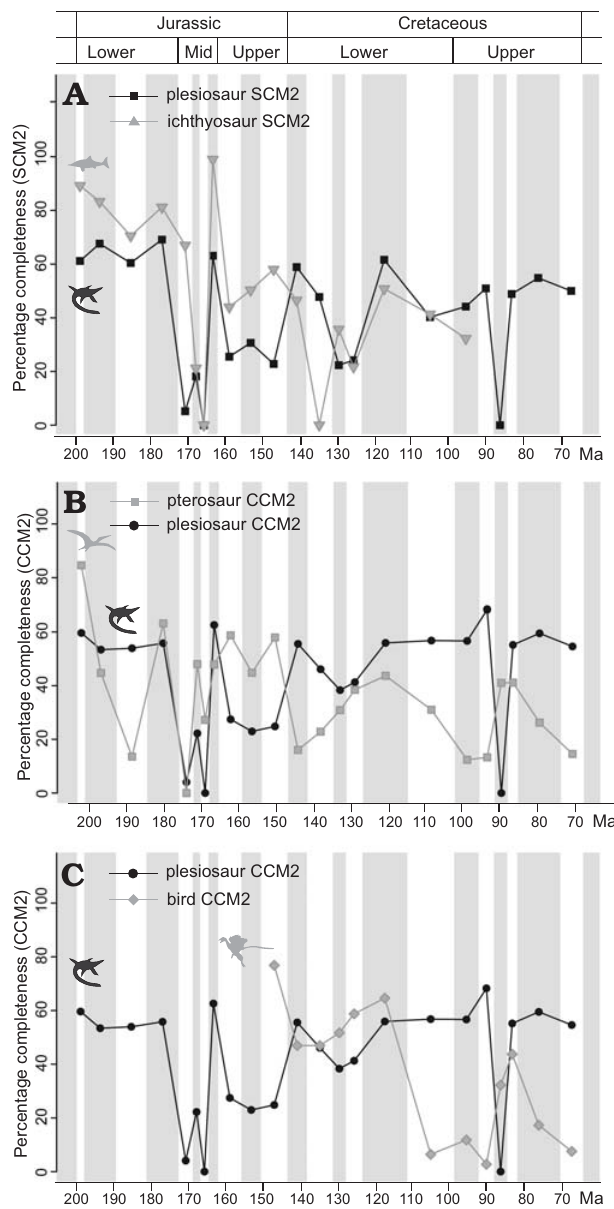
Fig. 4. Changes in skeletal completeness through time. A . Plesiosaur SCM2 and ichthyosaur SCM2. B . Plesiosaur CCM2 and pterosaur CCM2. C . Plesiosaur CCM2 and Mesozoic bird CCM2. Silhouettes are from phy- lopic.org, and are credited to Adam Stuart Smith ( Plesiosaurus ), T. Michael Keesey ( Archaeopteryx ), and Gareth Monger ( Pterodactylus , Ichthyosaurus ). Abbreviations: CCM, character completeness metric; SCM, skeletal com- pleteness metric (for detailed explanation of terms see Completeness met- rics in Methods